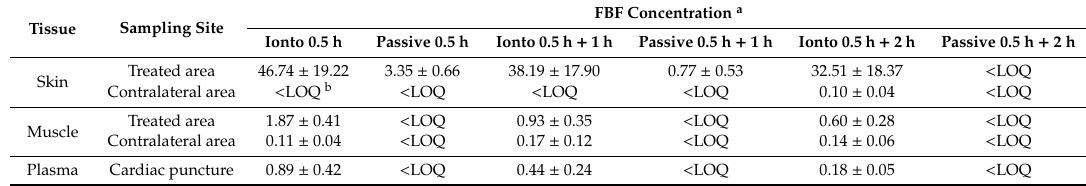
Table 4. FBF biodistribution after topical delivery ( n = 5 or